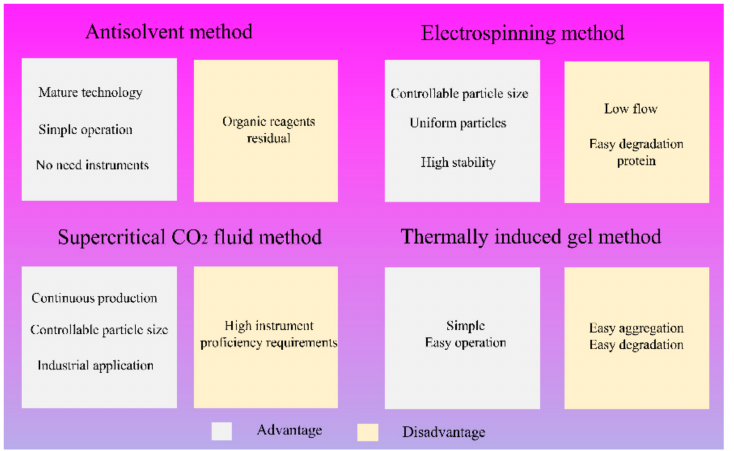
Figure 2. Schematic diagram of advantages and disadvantages of different methods for preparing protein-based